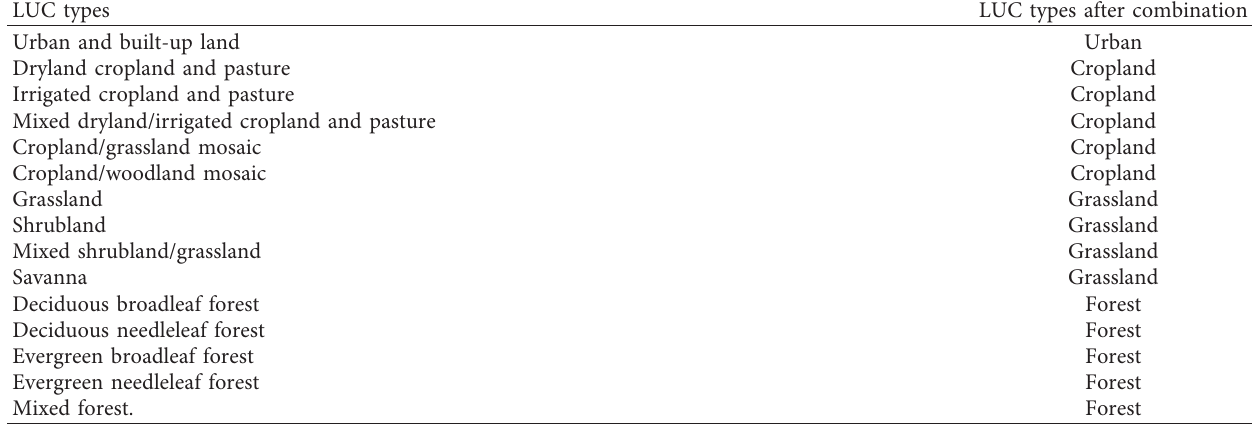
Table 3: Mapping for LUC